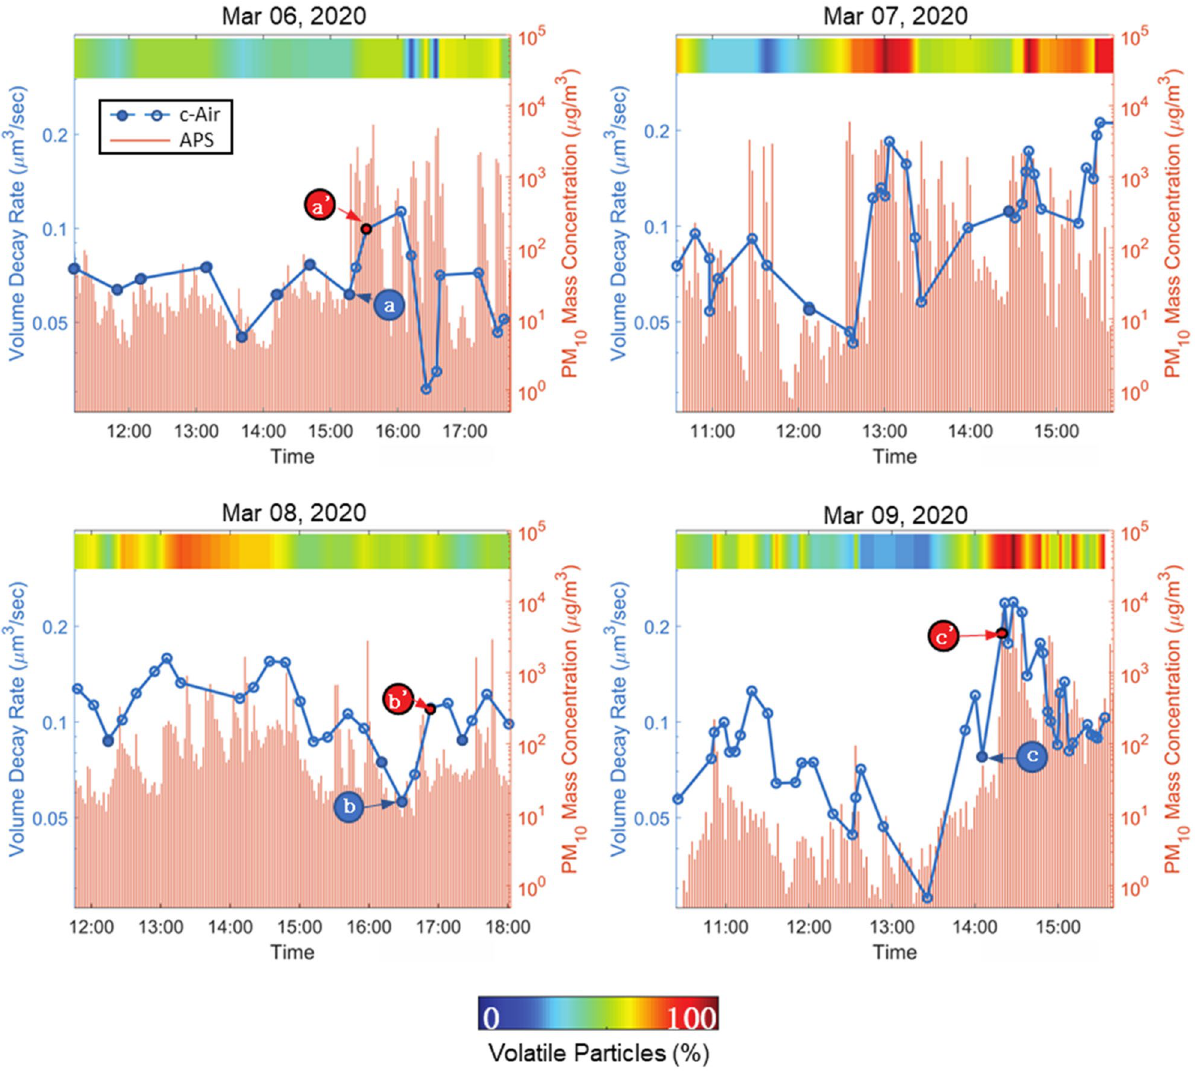
Figure 3. The change of the mean volume decay rate and the percentage of volatile aerosols throughout different days of experiments. Solid points refer to the pre-vaping measurements. a , b and c mark the data points where there was no observation of a vaping event prior to c-Air sampling, whereas, a ’, b ’ and c ’ mark the measurement points where vaping was observed in the vape Fig. S2, which tests the null hypothesis that the volume decay rates are sampled from continuous distributions with equal medians. A statistically significant increase in the volume decay rate of post-vaping aerosol measure- ments was observed with p < 0.05. As part of this analysis, we focused on three pre-vaping measurements, i.e., a, b and c marked in Fig. 3, that were conducted while no human vaping was observed in the vape shop. Given the dynamic indoor environmental conditions throughout a day, in terms of e.g., temperature, humidity and opening/closing of the outside door, these vape-free measurements within the vape shop can be considered as a background state for comparison purposes. An increase in aerosol volatility and volatile particle ratio can be clearly seen in the following three subsequent measurements points a’, b’ and c’ (see Fig. 3) during which the customers in the shop vaped, significantly increasing the e-cig generated aerosols. Note that these time spots were not the only vaping events observed in our field testing. Furthermore, dense and rapid vaping events within the vape shop also increased the aerosol volatility that we measured. For example, a continuous burst of vaping was observed close to our c-Air device on March 9th, at around 14:30 PM (Fig. 3). As a result of this continuous vaping within the shop, a sharp rise in PM 10 emission, particle volatility, as well as volatile particle ratio, is clearly observed in Fig. 3. In this case, c-Air measurements revealed that > 95% of the particles fell in the category of volatile particles and the measured volume decay rates were also notably higher compared to other measure- ment points within the same day, which shows how dense, successive vaping events can significantly increase the aerosol volatility within a room. Several limitations of the presented research might affect its generalizability. First, the chemical composi- tion of secondhand e-cig aerosols remained unknown during the field testing (involving unknown, random